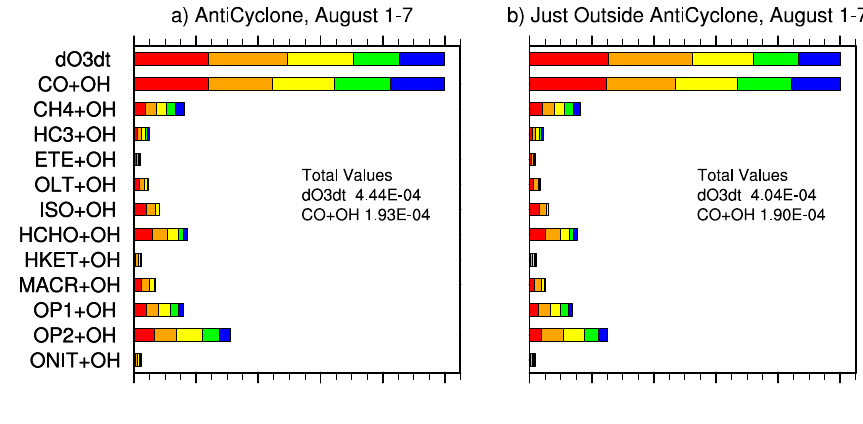
Fig. 14. The contribution of various VOC oxidation reactions to peroxy radical formation is shown as a function of the age of air for inside (left panel) and just outside (right panel) the UT Anticyclone. Each contribution is averaged in the upper troposphere (8–12km altitude range) over one of the time periods described in the meteorology section of the paper. The dO 3 d t and CO + OH rates are normalized by their total value (listed in the panel) in the region and time period, while the other reaction rates are normalized by the CO + OH total value in the region and time period. The horizontal area of the Anticyclone is defined as the region by z > 9730m at 300hPa. The horizontal area of the Just Outside Anticyclone region is defined as the region by 9730m >z > 9680m at 300hPa and only includes grid points within 600km of the